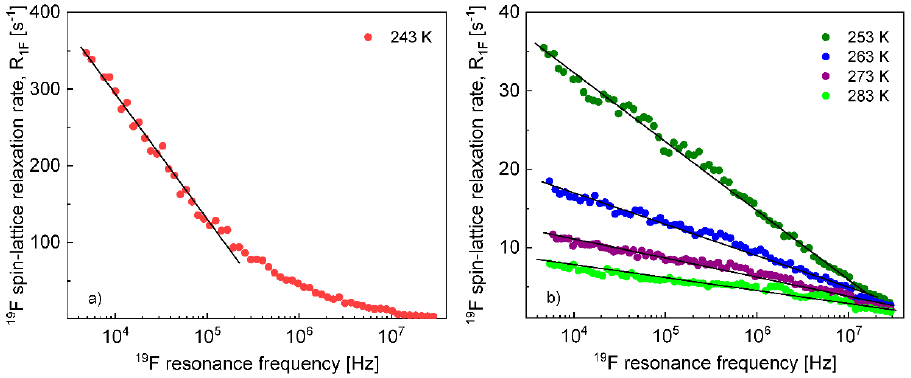
Figure 6. 19 F spin–lattice relaxation rates for EMIM-FSI in the silica matrix at ( a ) 243 K and ( b ) from 253 K to 283 K; lines—linear dependencies characteristic of 2D translation diffusion.